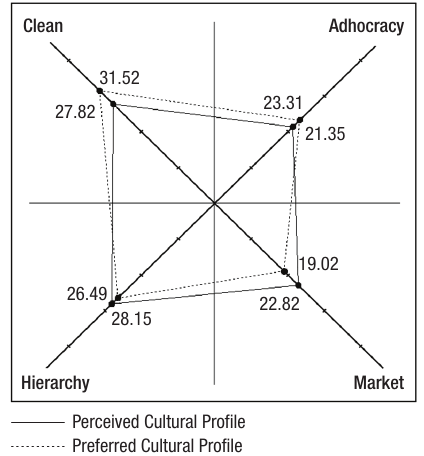
Fig. 2. Cultural profi le of